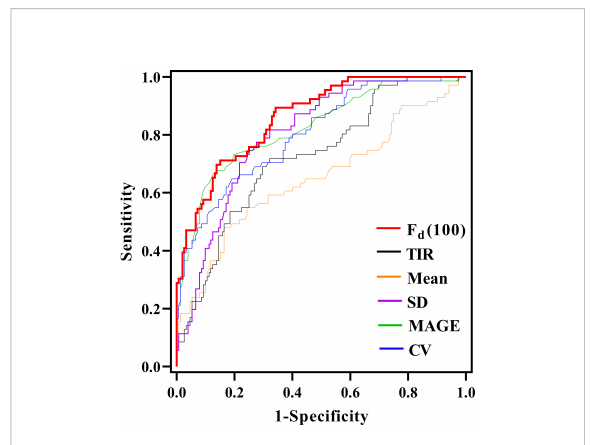
FIGURE 3 Comparison of the area under the curve (AUC) for glycemic parameters in discriminating between LADA and T2D through receiver operating characteristic